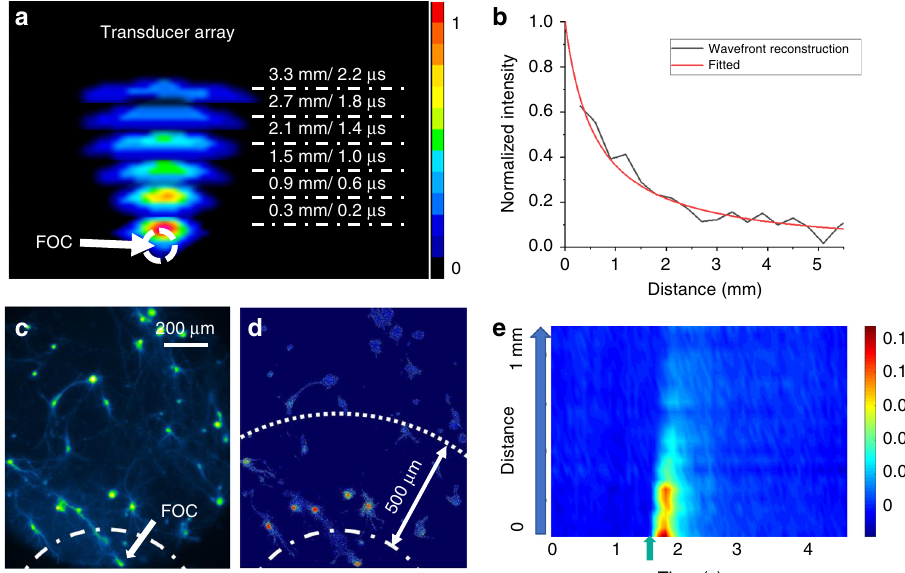
Fig. 3 Spatially con fi ned acoustic wave and neural stimulation induced by FOC. a FOC wavefront reconstruction by the transducer array. Note only part of the wavefront is reconstructed due to the limited receptive angle of the transducer array. b Acoustic intensity attenuates signi fi cantly as the distance to the FOC increases. c , d Spatial distribution of maximum neuronal calcium response induced by 200 ms FOC stimulation. Dashed line: placement of FOC. e Sorted calcium traces of neurons by the distance from the cell to the FOC. Green arrow: stimulation onset. Source data are provided as a Source Data fi